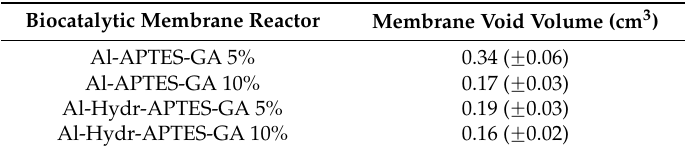
Table 2. Virgin membrane void volumes of the biocatalytic membrane